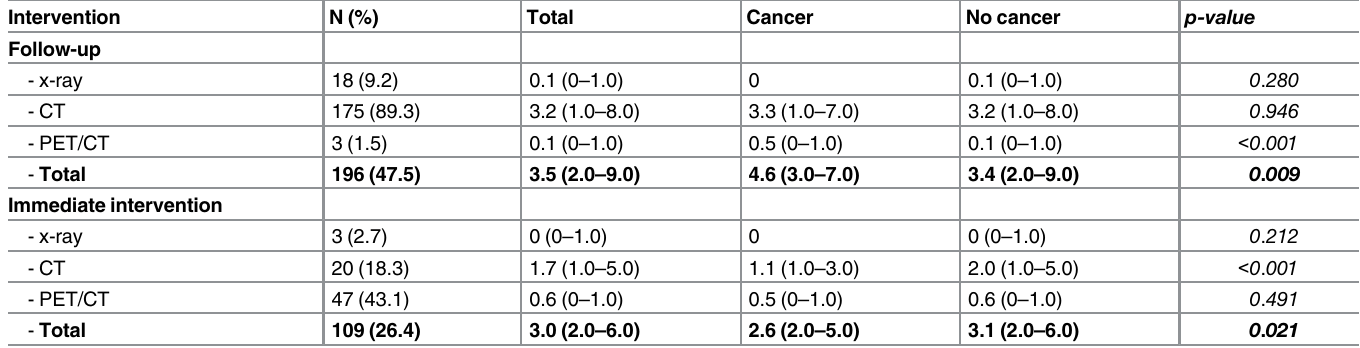
Table 7. Analysis of the number of imaging tests (mean, minimum, maximum) associated with the management of SPN for CT according to the management strategy and for patients with a final diagnosis of lung cancer and those without it.